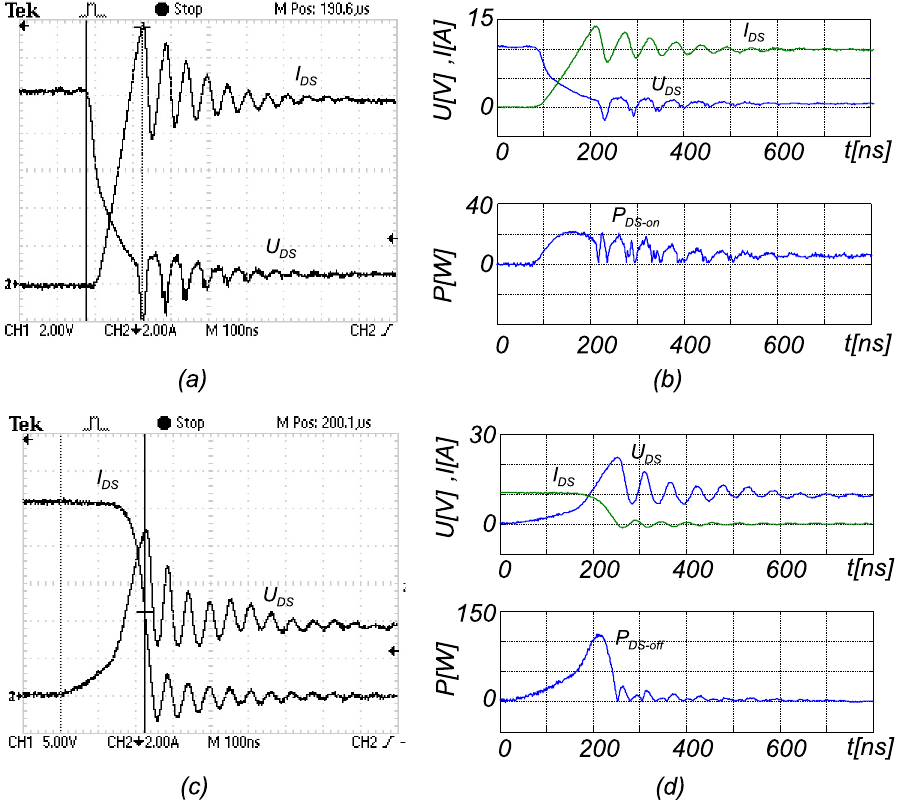
Figure 7. MOS-FET’s turn-on/-off waveforms; ( a ) oscillogram of voltage U I during the switching-on; ( b ) oscillogram exported to the MATLAB frame for the D calculation of switching on dissipation; ( c ) oscillogram of voltage U during the switching off; ( d ) oscillogram exported to the MATLAB frame for calculation of switching off